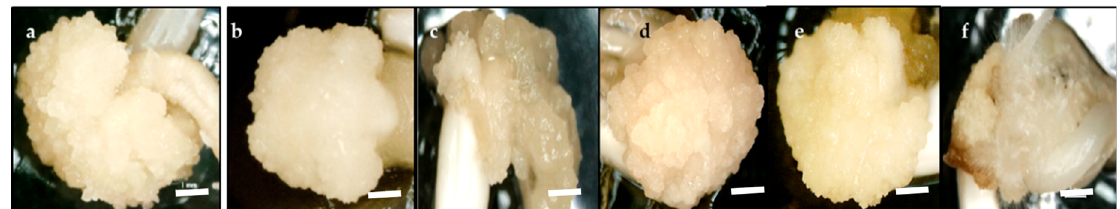
Figure 1. The embryogenic calli ( a – c ) MR220 and ( d – f ) MR220-CL2 after 3 weeks cultured. ( a , d ): Embryogenic calli were compact, nodular structure with light yellowish color at MS medium with 3 mg / L 2, 4-D. ( b , e ): Non-embryogenic calli were friable, watery-surface, and loosely held cells on the surface found on N 6 medium added to 3 mg / L 2, 4-D; ( c , f ): Non-embryogenic calli were smaller and loosely held cells on the surface found on N 6 medium added with 5 mg / L 2, 4-D (Bar = 1